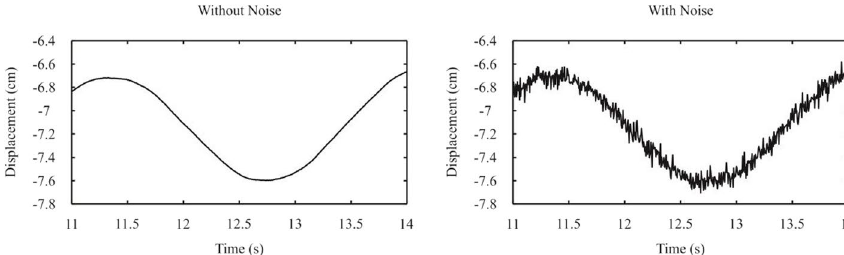
Fig. 15 The displacement response signal of the intact bridge deck in the ideal and noisy state